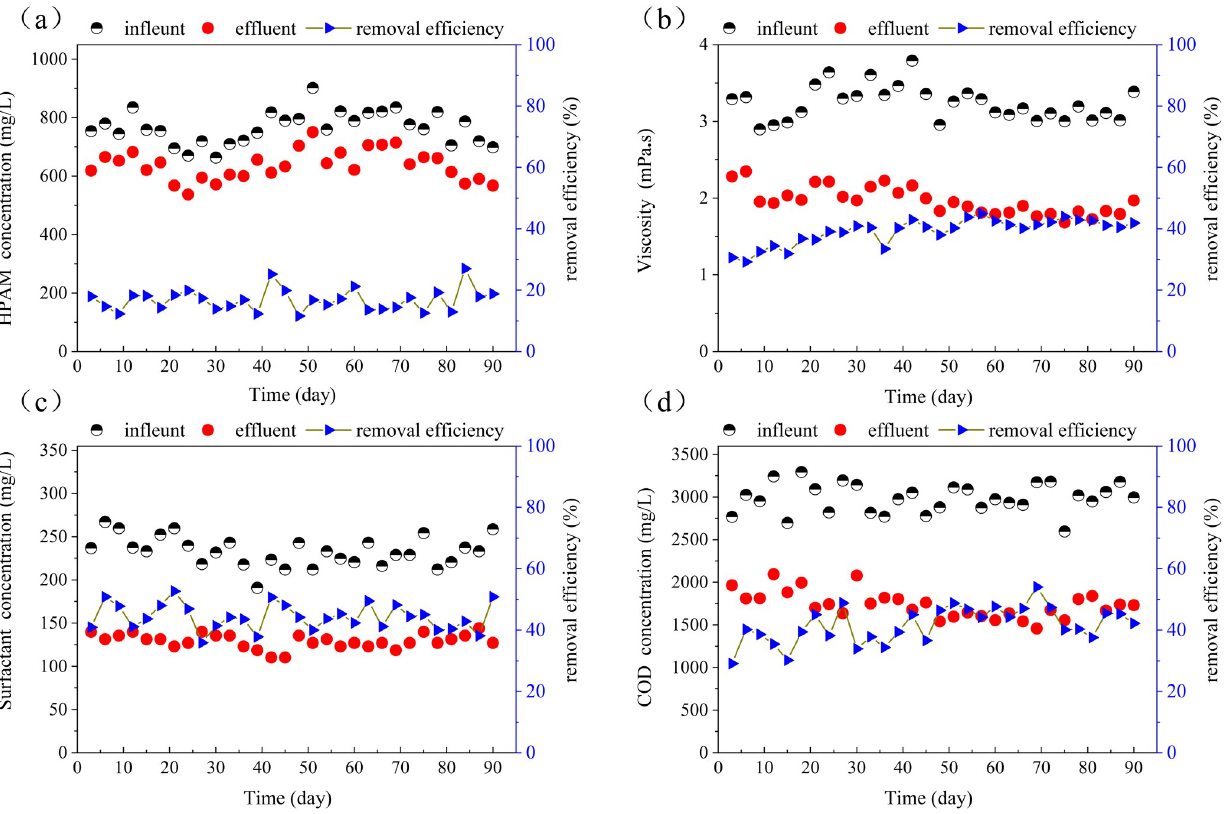
Fig 2. Treatment efficiency of the modified ABR reactor for the remediation of ASP flooding wastewater. (a) HPAM removal; (b) viscosity change; (c) surfactants removal; and (d) COD change.